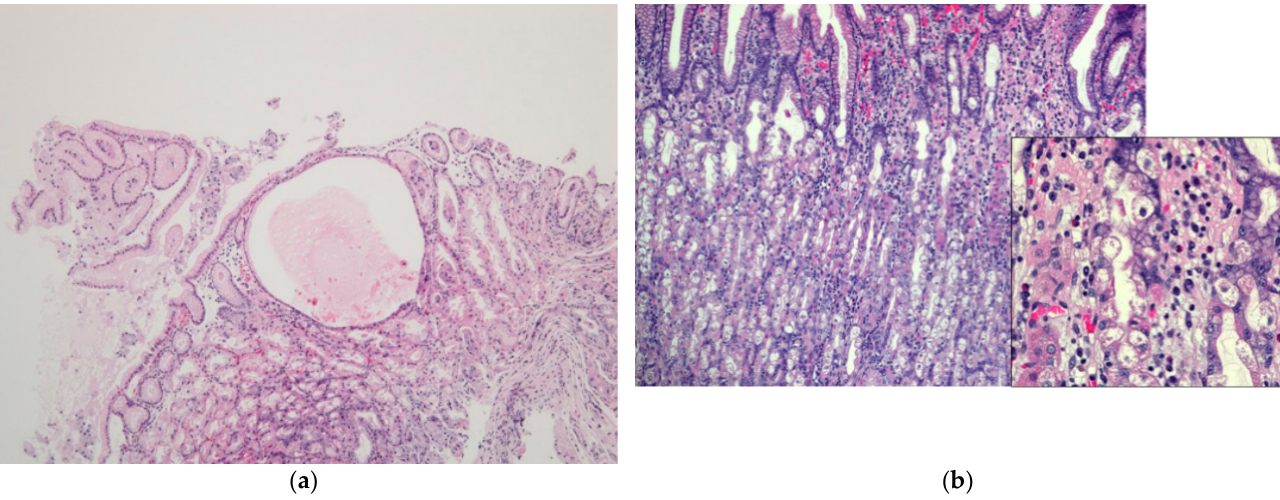
( c ) Figure 5. Endoscopic images of white spot: ( a ) multiple white spots at the fornix of the stomach; ( b ) nonatrophic mucosa with a round pit surrounded by white spot on magnifying narrow-band imaging; ( c ) gastric-cracked mucosa (a proton- pump-inhibitor-related lesion) in a patient with white spot.